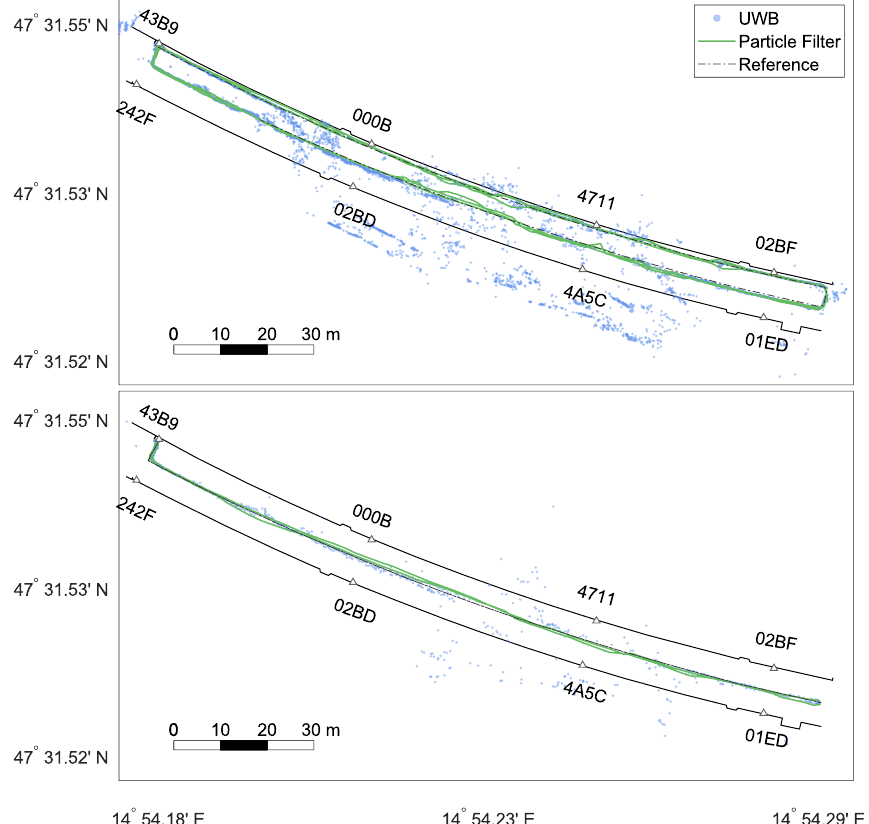
Figure 14. Filter solutions of Tests 3 (top) and 4 (bottom). In Test 3, the operator walks 3 times along the wall and centre line, whereas Test 4 contains running along the centre line. UWB data are additionally plotted to highlight interference areas due to parked vehicles. The UWB anchors are marked as